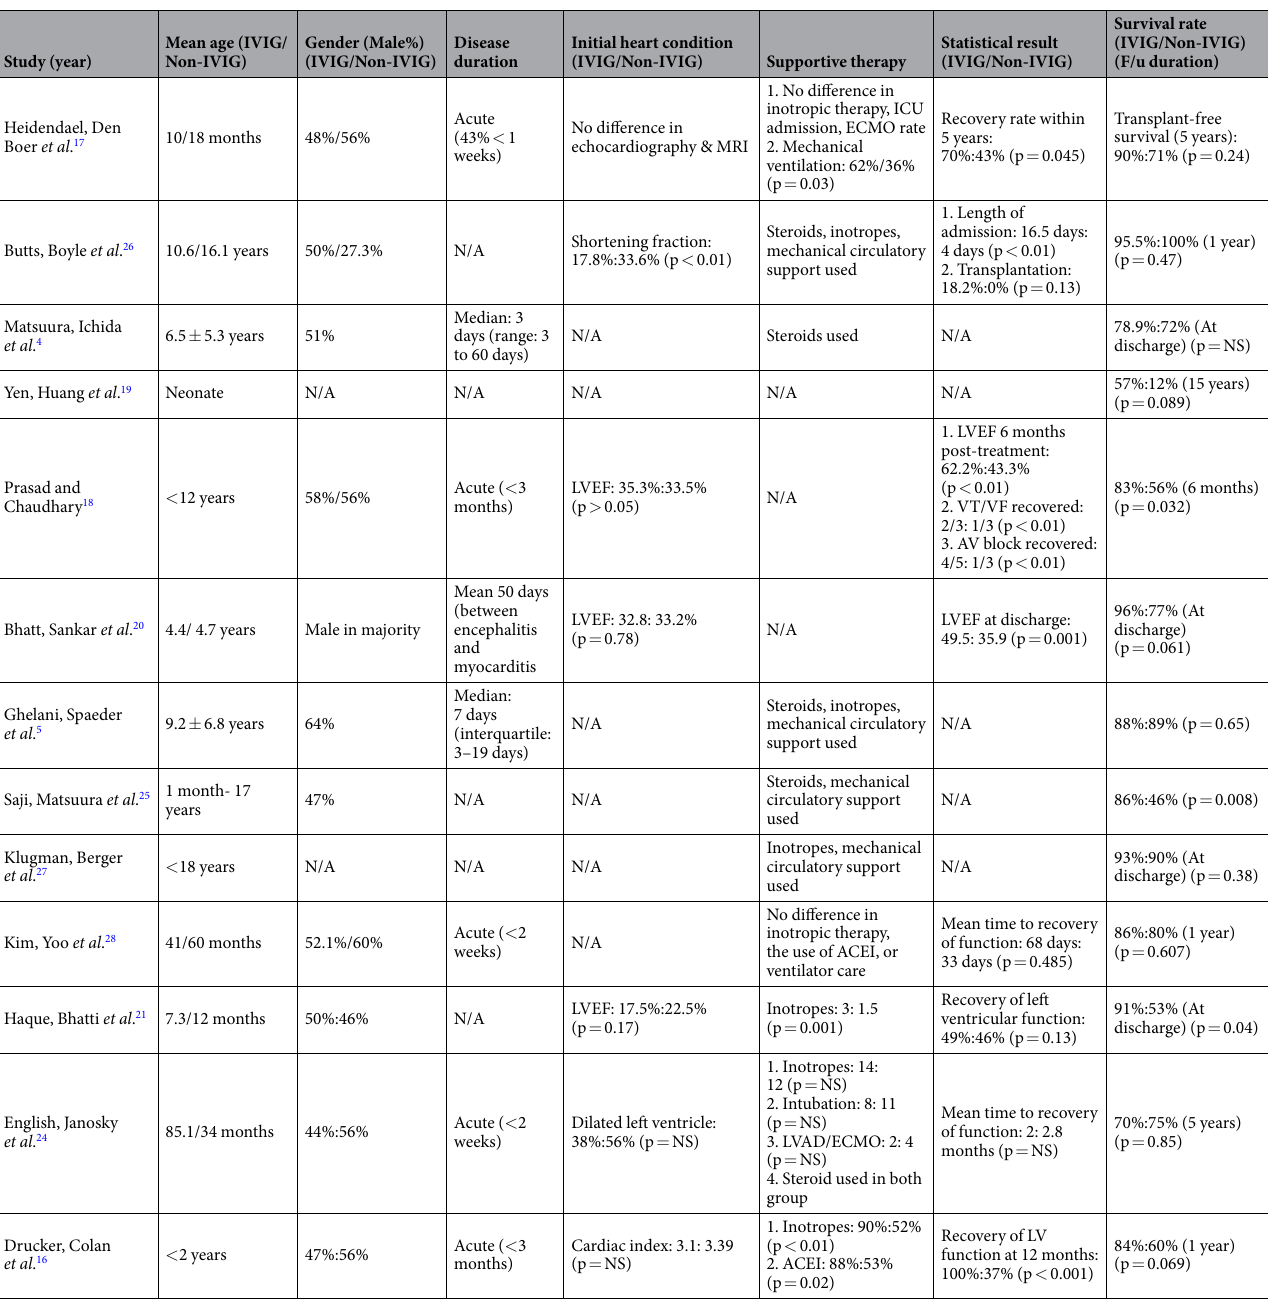
Table 2. Summary of the clinical and statistical data of the included studies. IVIG: intravenous immunoglobulin, MRI: Magnetic resonance imaging, ICU: intensive care unit, N/A: not available, LVEF: left ventricular ejection fraction, NS: not significant, LVAD: left ventricular assist device, ECMO: extracorporeal membrane oxygenation, VT/VF: ventricular tachycardia/fibrillation, AV: atrioventricular, ACEI: angiotensin- converting enzyme